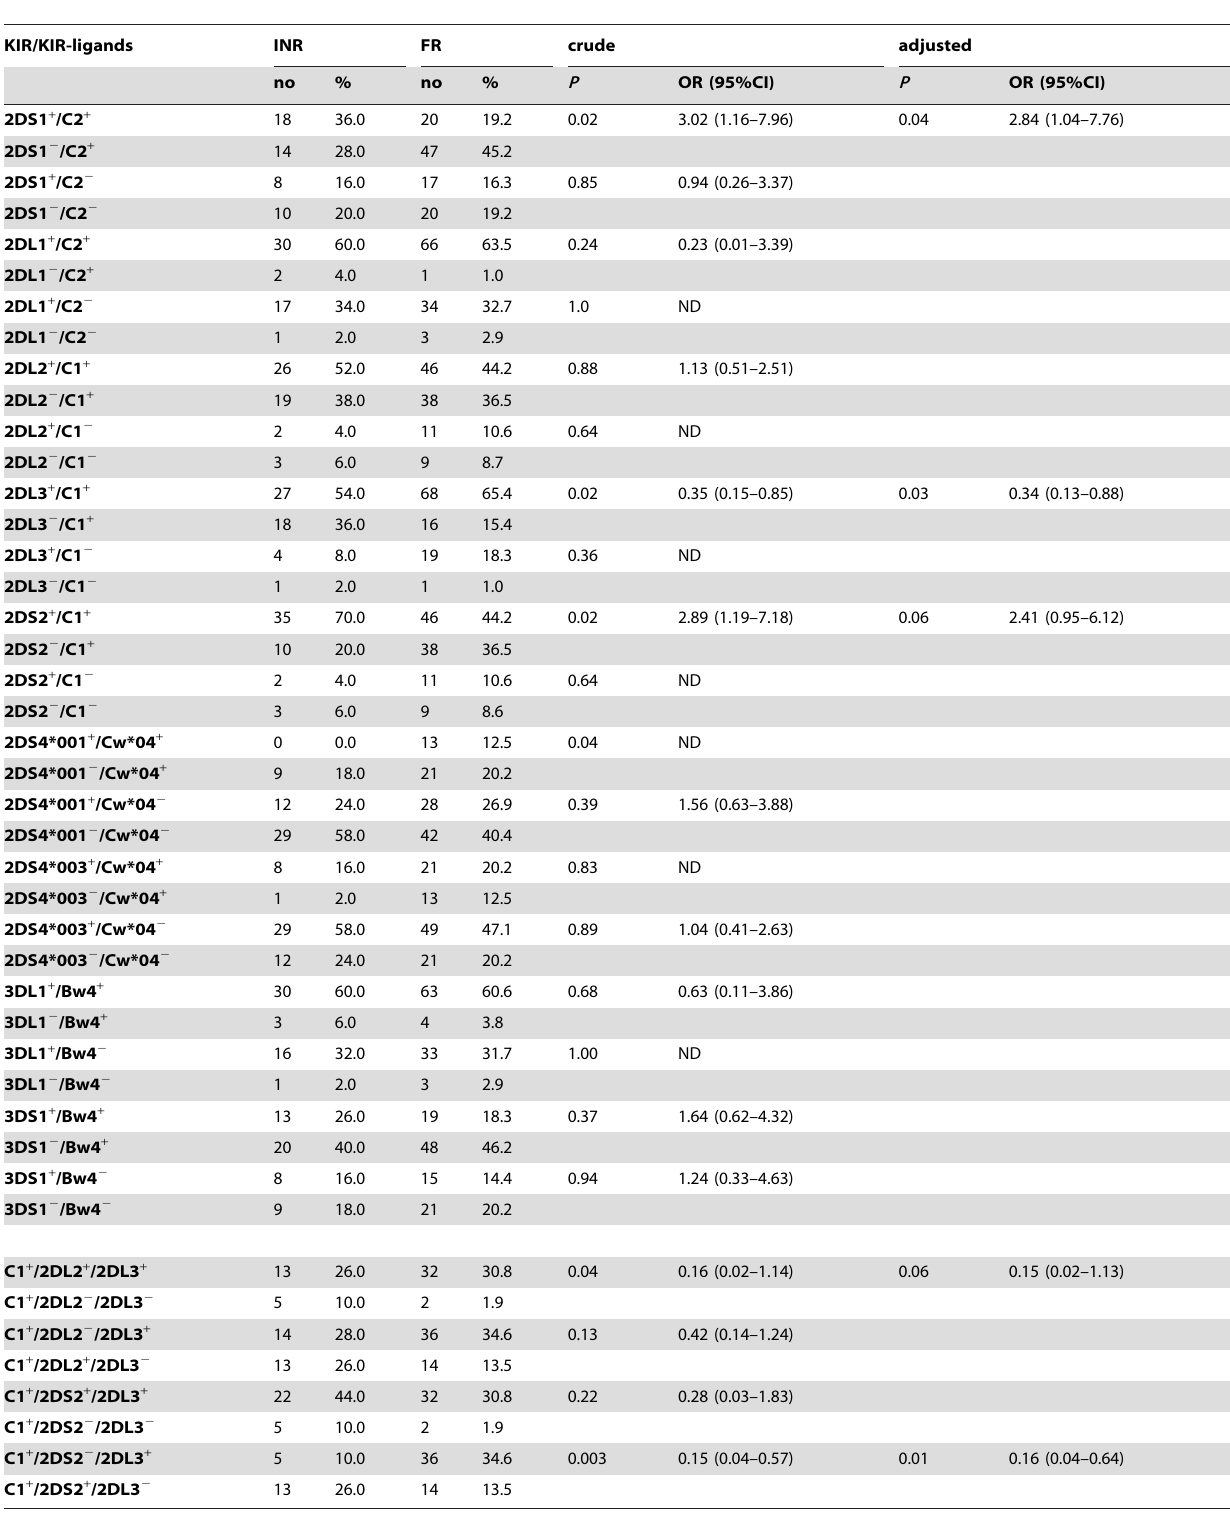
Table 4. Distribution of KIR/KIR-ligands co-presence in full responders (FR) and immunological non responders (INR). Analysis is adjusted for nadir CD4 + T-cell